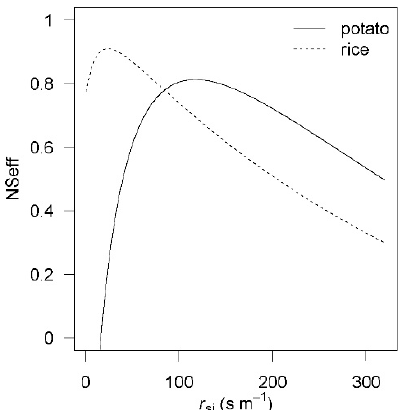
Figure 5. Nash-Sutcliffe model efficiency coefficient (NSeff) of PM-FAO (Penman-Monteith-Food and Agriculture Organization) modelled Q E to modifications in r si for the potato field (solid line) and rice field (dotted line).